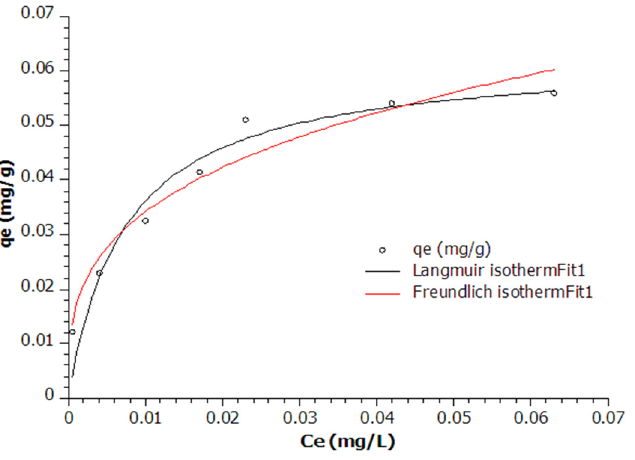
Figure 8. The Langmuir and Freundlich isotherms for As(V) adsorption (Conditions: pH = 5, dose 2 g/L (100 mg/50 mL) and temperature 25 °C).